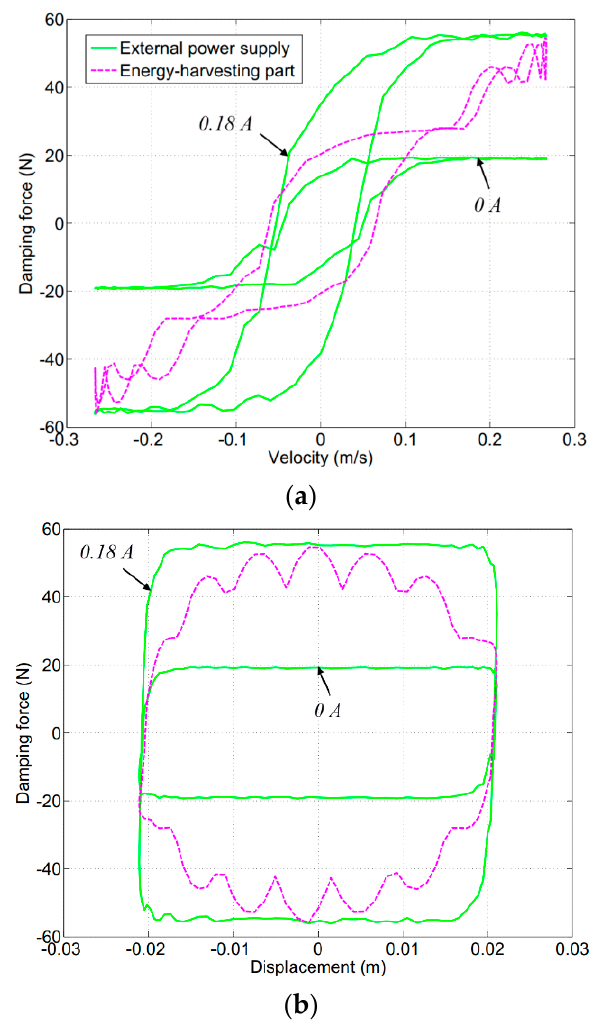
Figure 17. Experimental results of the MR damper with the EH part and under constant external currents in the case when the excitation is 2 Hz frequency and 21 mm amplitude: ( a ) force vs. velocity and ( b ) force vs. displacement.